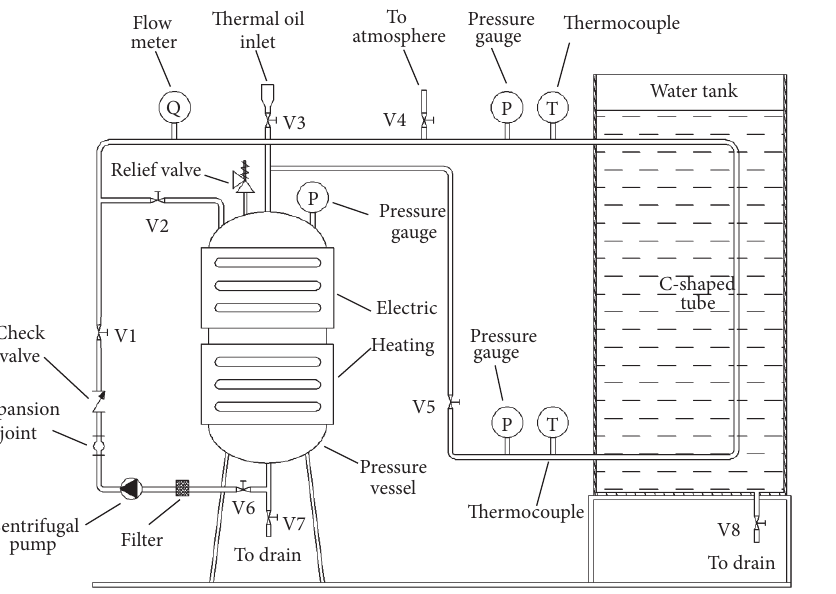
Figure 1: Experimental apparatus diagram.